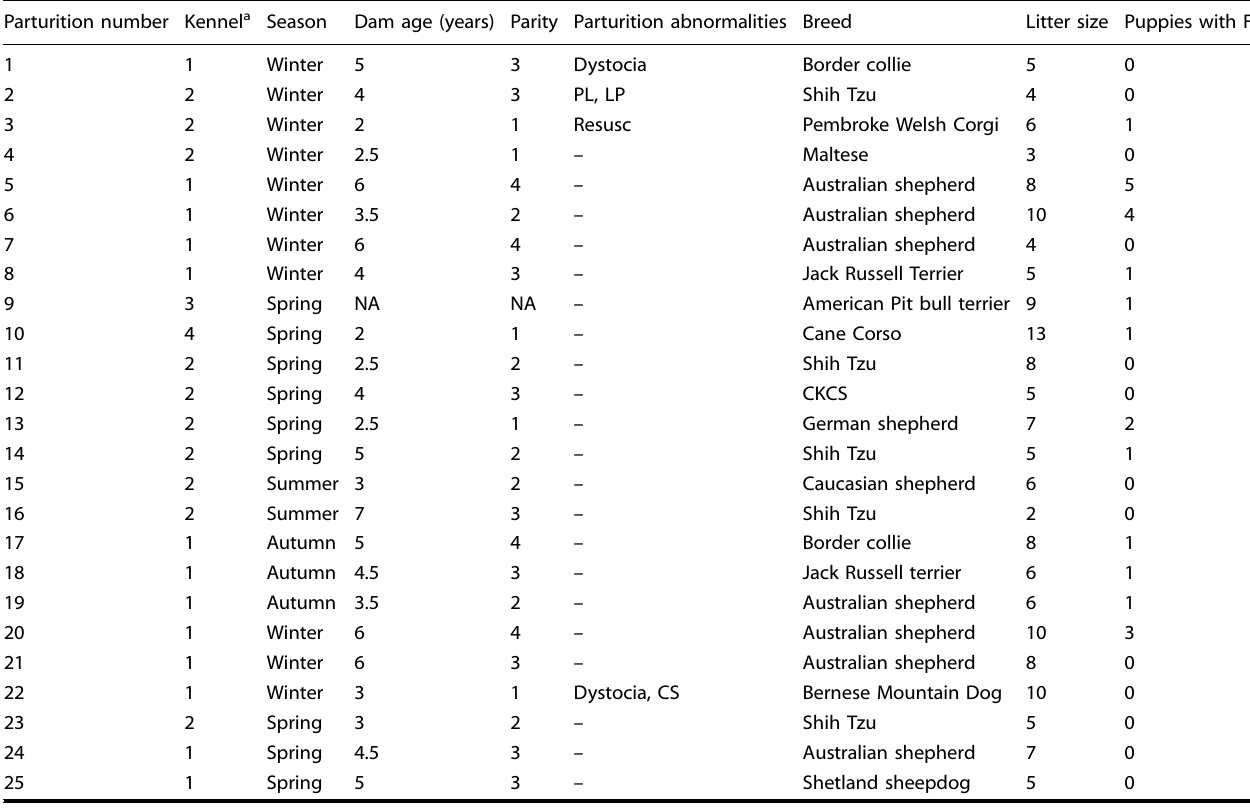
Table 1. Demographic data of 25 dams and their litters, and occurrence of parturition abnormalities and fading puppy syndrome. Parturition number Kennel a